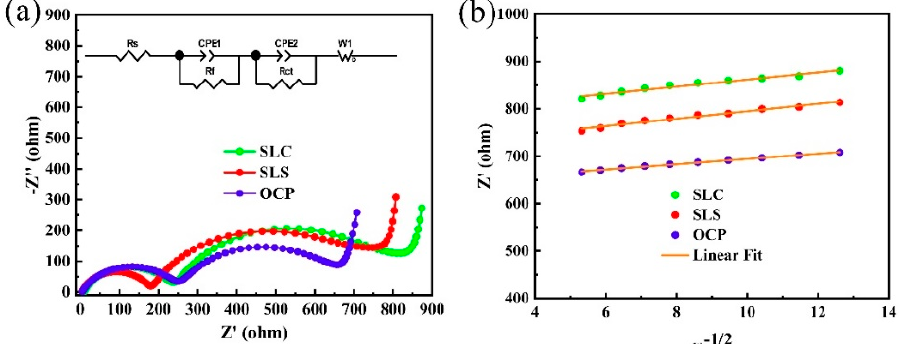
− 1 / 2 for LL-811 samples after the